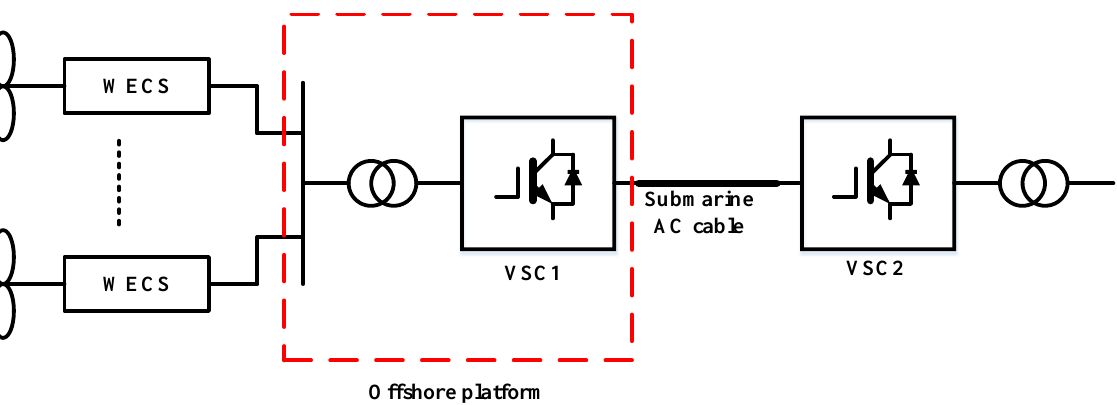
Figure 2. HVDC offshore wind connected in parallel [24].